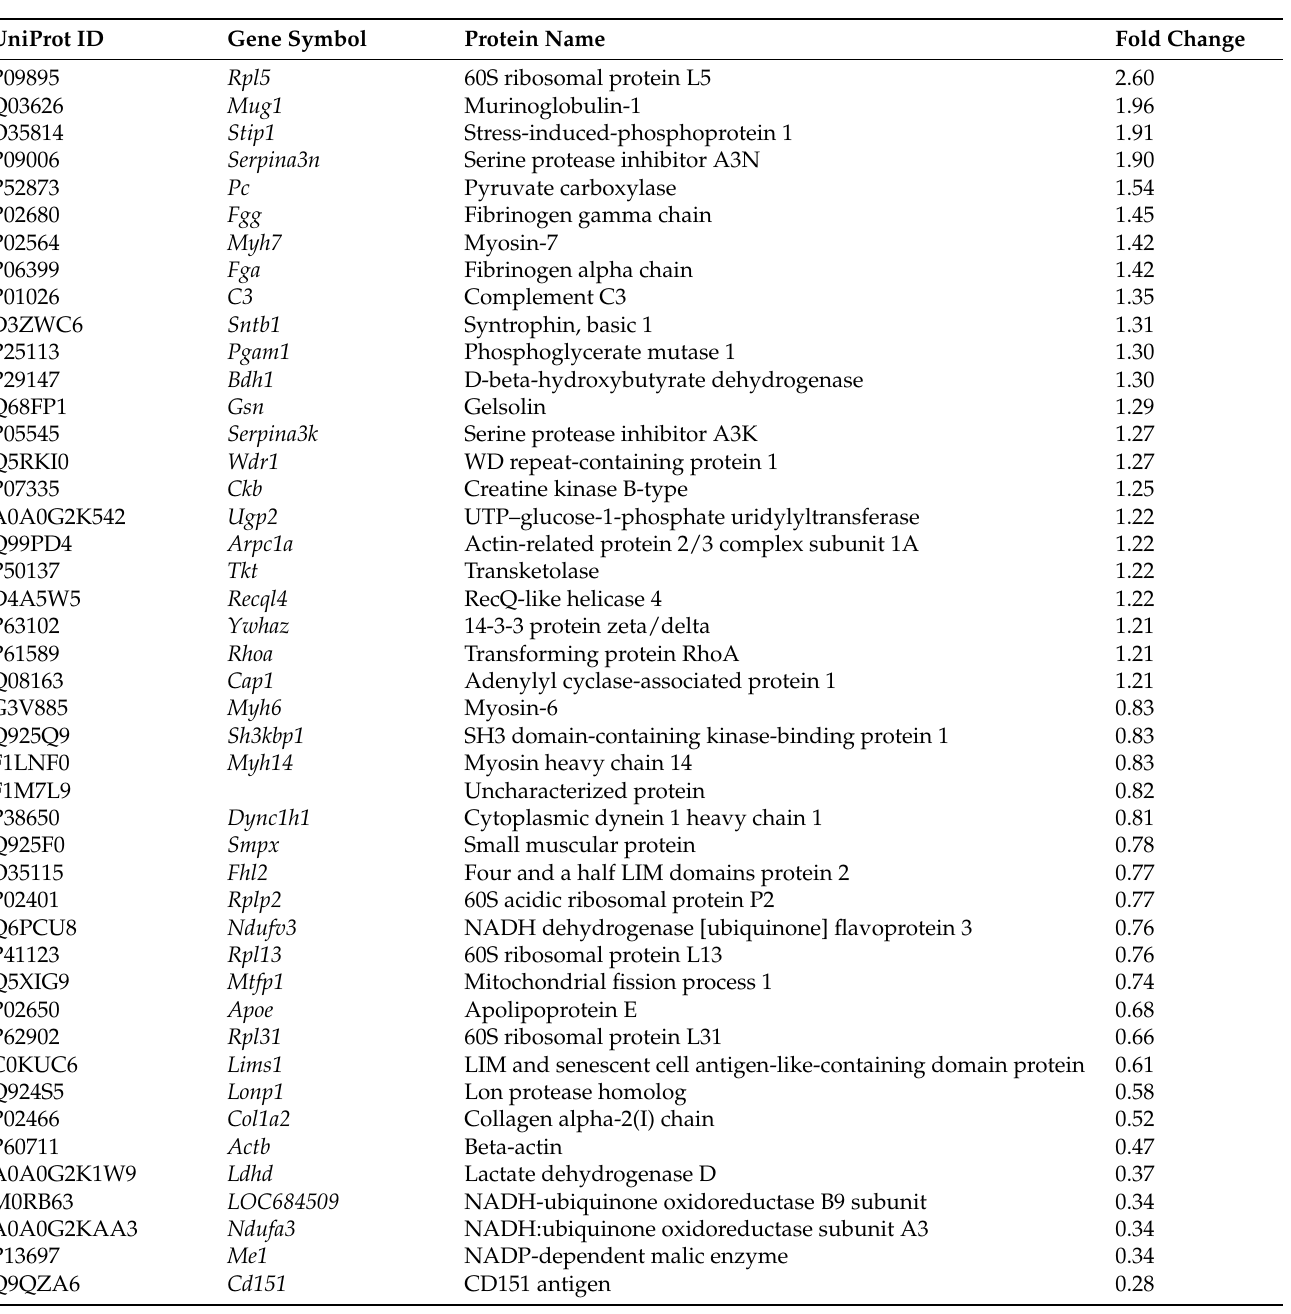
induced by hypercholesterolemia in the left ventricles of rats. Each dot represents one distinct protein. The downregulated (blue) and upregulated (red) proteins are highlighted in the plot. The dashed line indicates the threshold value of significance ( − log 10 1.3<) The differentially expressed proteins are listed in Table 3. Table 3. List of hypercholesterolemia-induced significant alterations in the left ventricular proteins. Proteins with fold changes of >1.2 or <0.83 were considered as significant. The fold change values are shown as ratio